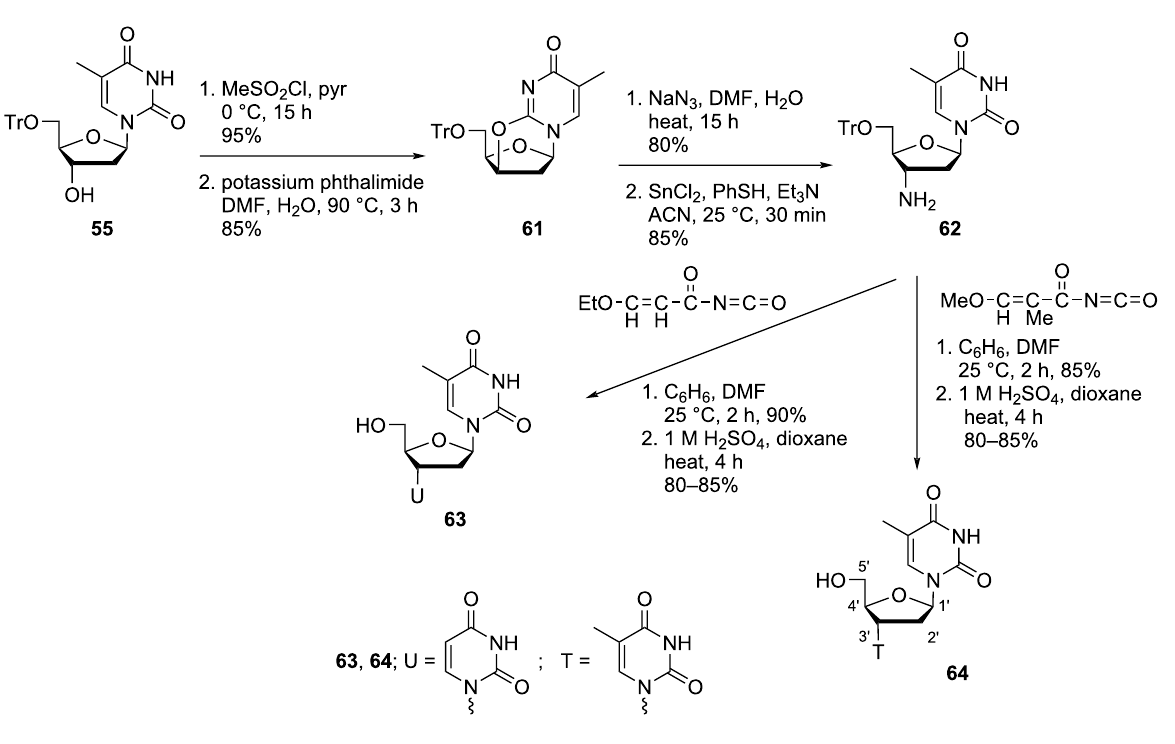
Scheme 14: Synthesis of the double-headed nucleosides 63 and 64 .